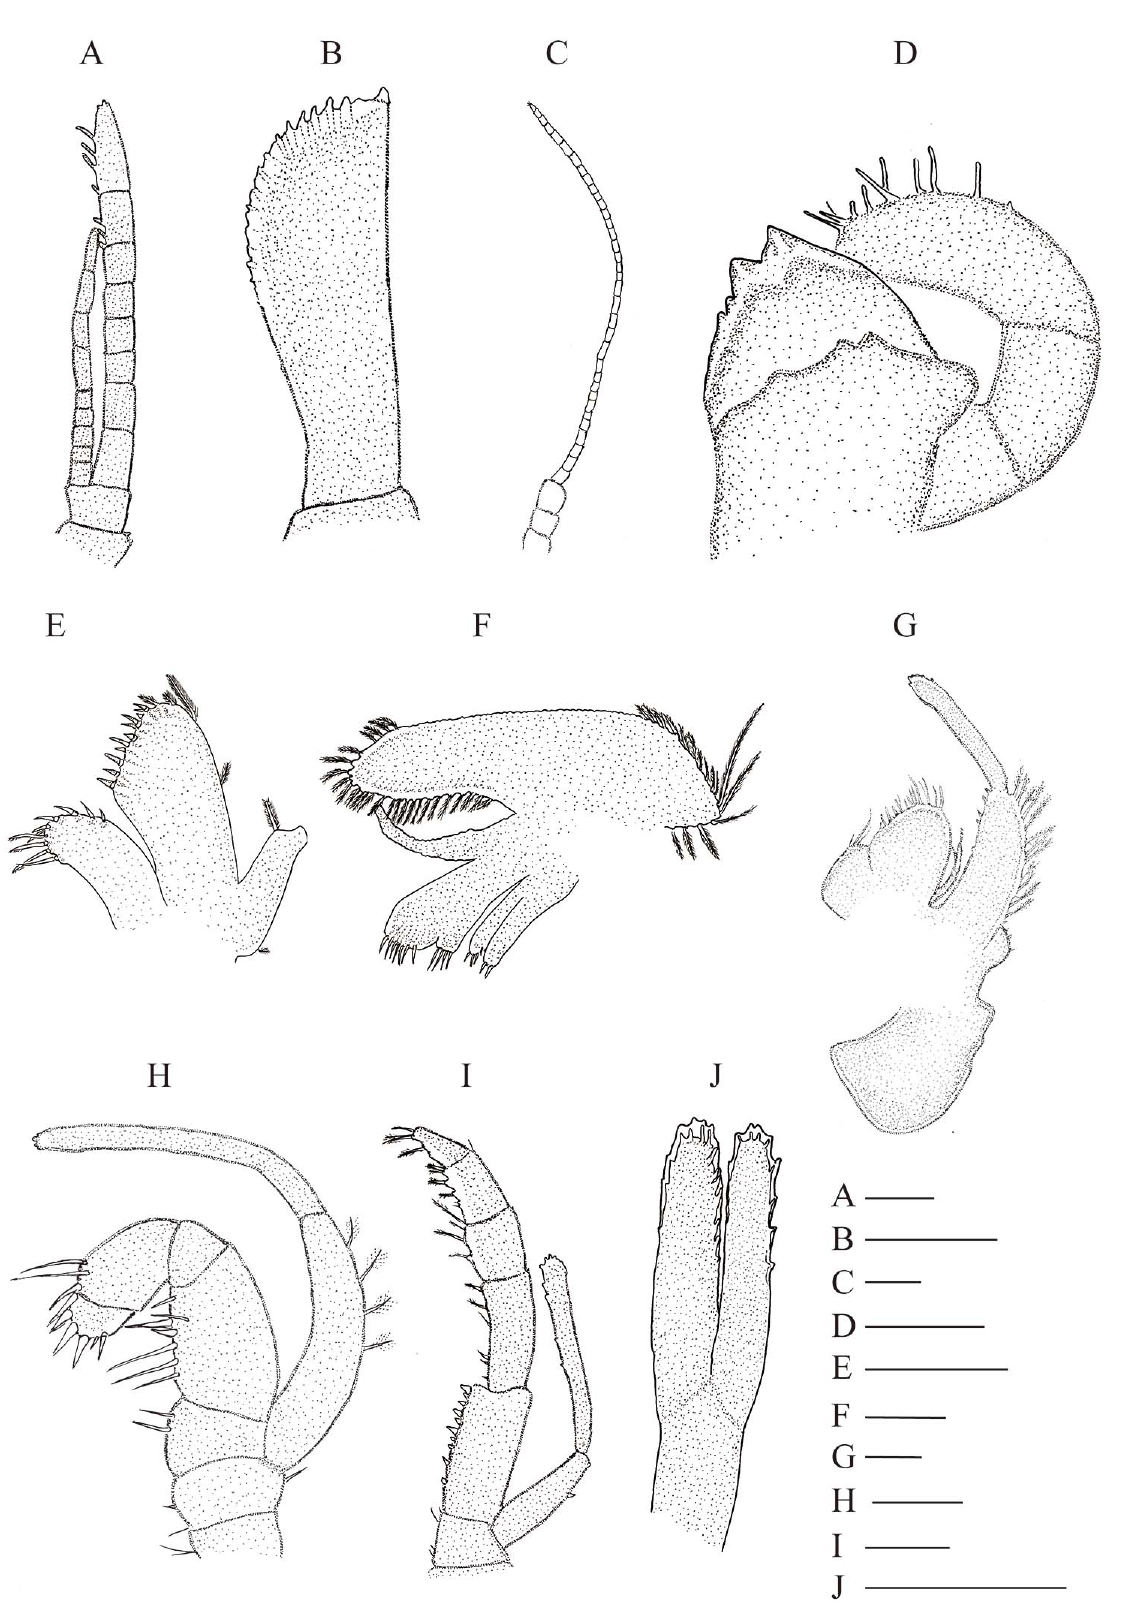
Figure 22. Juvenile Stage II of Cherax destructor . ( A ) Antenna 1, dorsal view; ( B ) antennal scale, dorsal view; ( C ) antenna 2, dorsal view; ( D ) mandible, view of inside of mouth; ( E ) maxilla 1, oral view; ( F ) maxilla 2, oral view; ( G ) first maxilliped, oral view; ( H ) second maxilliped, oral view; ( I ) third maxilliped, oral view; ( J ) pleopod. Scale bars: 0.25